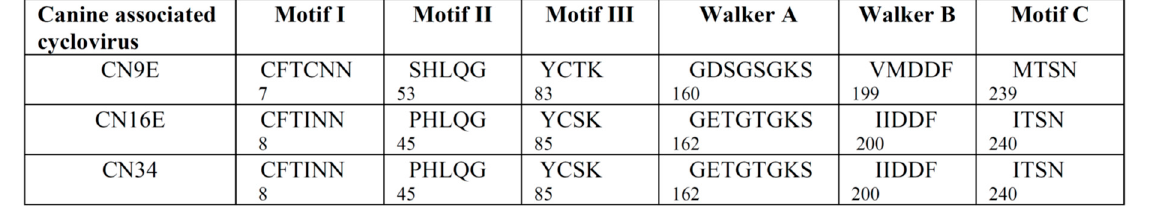
Figure 3. Phylogenetic analysis based on the complete genome sequences of canine-associated cy-